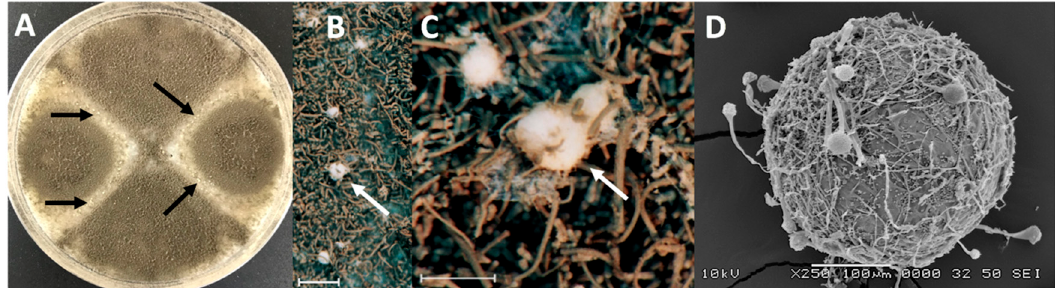
Figure 1. Production of cleistothecia by A. fumigatus in crosses with Irish tester strains. ( A – C ) Cleistothecia (arrowed) formed along the junctions (barrage zones) of intersecting colonies of opposite mating type. Scale bars = 1 cm. ( D ) Scanning electron micrograph of a cleistothecium showing attachment of superficial conidiophores. (Images A and D courtesy of George Ashton and Paul Brett, University of Nottingham).